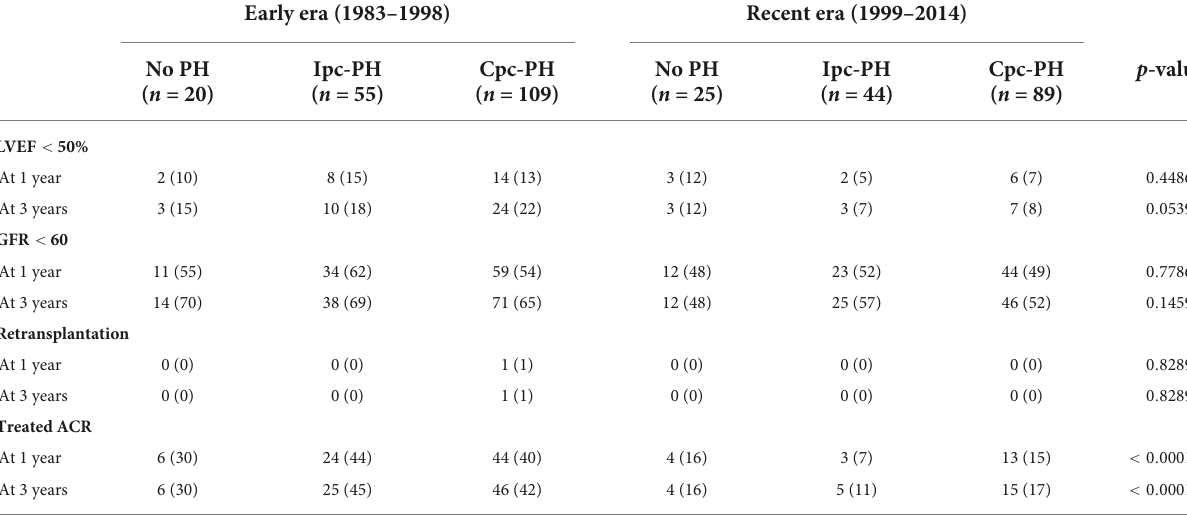
TABLE 3 Selected events up to 3 years following CTx according to the era of transplantation and the severity of PH. Early era